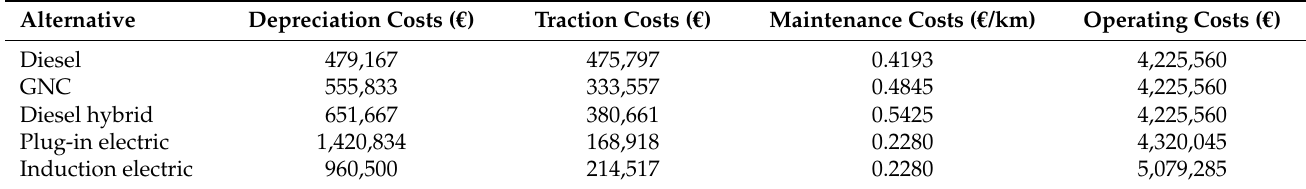
Table 8. Data for the analysis of depreciation costs by type of